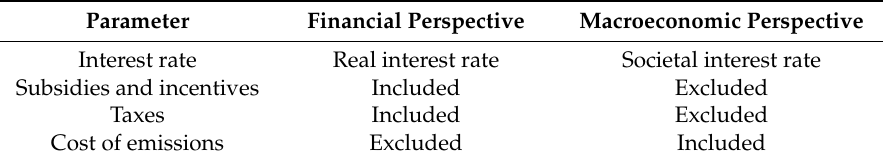
Table 1. Assumptions for private and societal perspectives. Adapted from [22].